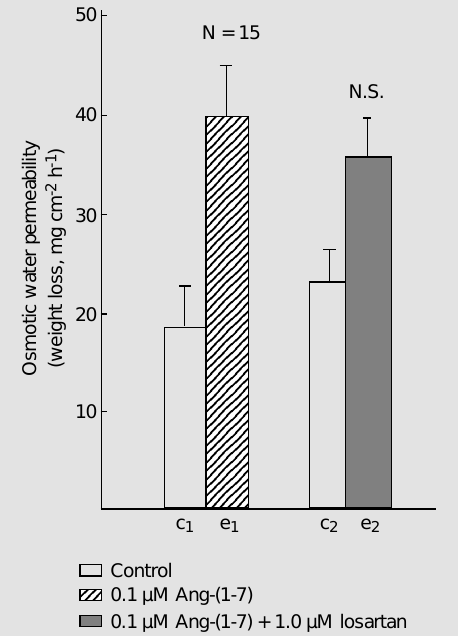
Figure 7 - Lack of effect of the specific antagonist of the AT 1 receptor losartan on osmotic water permeability stimulated with Ang-(1-7). Data are reported as means ± SEM. One-way ANOVA followed by the New- man-Keuls test showed no sig- nificant differences (N.S.) be- tween e 1 and e 2 or c 1 and c 2